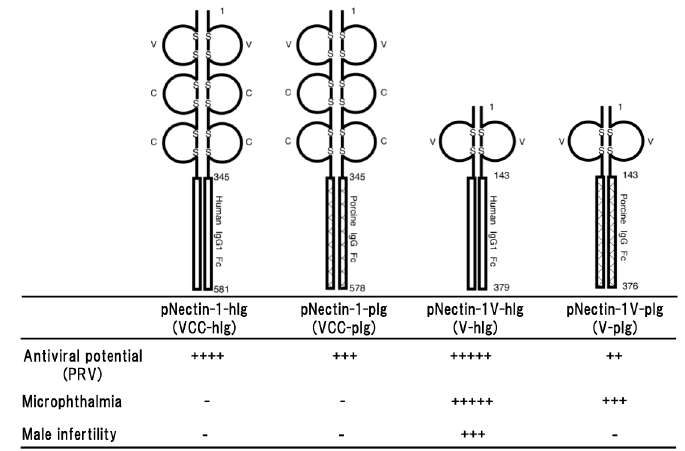
Figure 1. Schematic representation of four different types of soluble forms of porcine nectin-1. The fusion proteins consist of the entire ectodomain (VCC) or the first Ig-like (V) domain of porcine nectin-1 and Fc portion of human IgG1 or porcine IgG (upper part) and the properties of four transgenic mouse lines (lower part). Antiviral potential against PRV infection [29,31], microphthalmia and male infertility [34] as a side effect are shown. Numbers on the figure are shown amino acids number of each molecule. S represents disulfide bond. + to +++++ indicate relative strength of the phenotype. − means no phenotype observed.